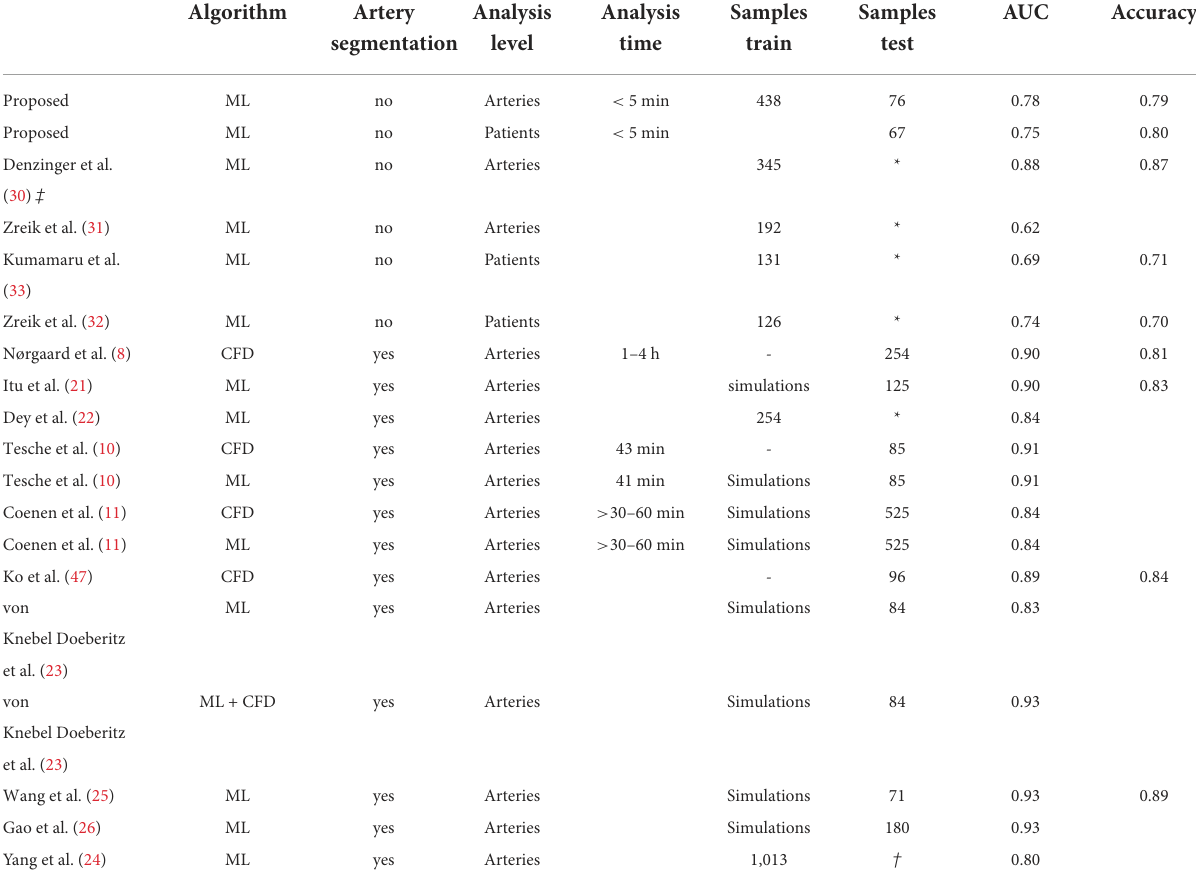
TABLE 7 Comparison of the performance on the Test Cath data set with previous